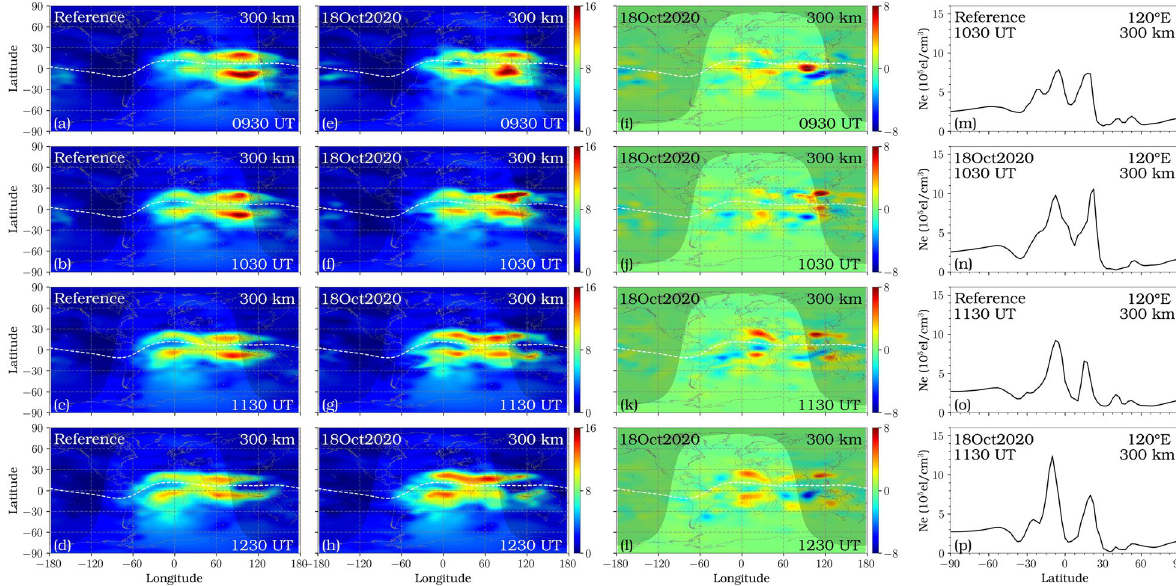
Fig. 10 The longitude–latitude maps of electron density at an altitude of 300 km obtained from the F7/C2 GIS data during 0930–1230 UT. a – d The average electron density during previous 5 days as reference. e – h The electron density on 18 October 2020. i – l the difference between the two. The white dotted line denotes the geomagnetic equator and the shaded region corresponds to post‑sunset period. The latitude profiles of electron density at selected periods of 1030 and 1130 UT at 120 E longitude on 18 October 2020 are shown in n and p to compare the PRE on this day with that on the reference day in m and